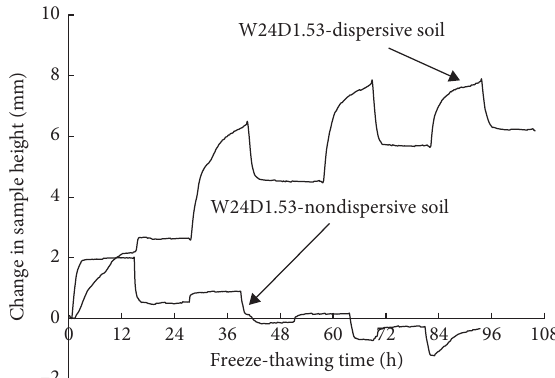
Figure 10: Freezing-thawing characteristics of dispersive and nondispersive soil.